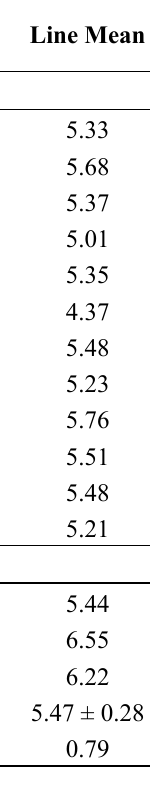
Table 4. Yield of barley lpa near-isogenic lines and three cultivar controls when grown in five locations in Idaho, 2011. Data represent means of four replicates at each location. Isoline